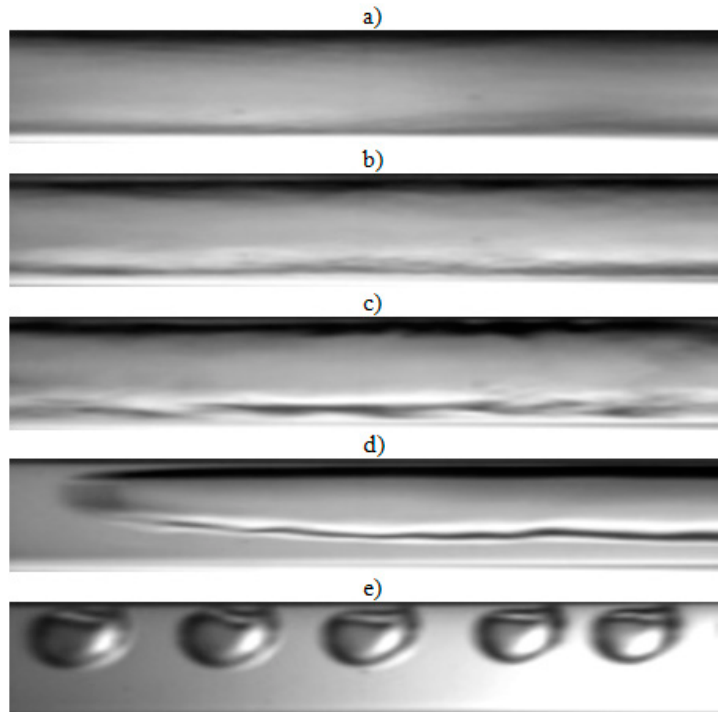
Figure 9. Experimental results of visualization research on Novec649 refrigerant condensation in a minichannel with an internal diameter d h = 1.2 mm: ( a ) mist flow G = 2187 kg/m 2 s, x = 0.042, ϕ = 0.82, t s = 61 °C; ( b ) annular flow G = 2015 kg/m 2 s, x = 0.029, ϕ = 0.75, t s = 54 °C; ( c ) annular ‐ wavy flow G = 2236 kg/m 2 s, x = 0.015, ϕ = 0.63, t s = 51 °C; ( d ) slug flow G = 1966 kg/m 2 s, x = 0.008, ϕ = 0.48, t s = 59 °C; ( e ) bubbly flow G = 1032 kg/m 2 s, x = 0.003, ϕ = 0.27, t s = 51 °C.